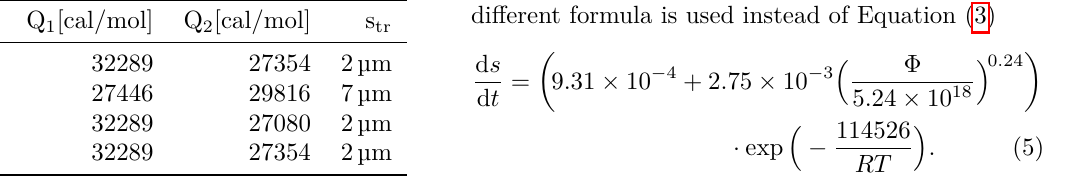
Table 2. Values of corrosion model’s constants used in corrosion models (2) and (3) as defined by [3].